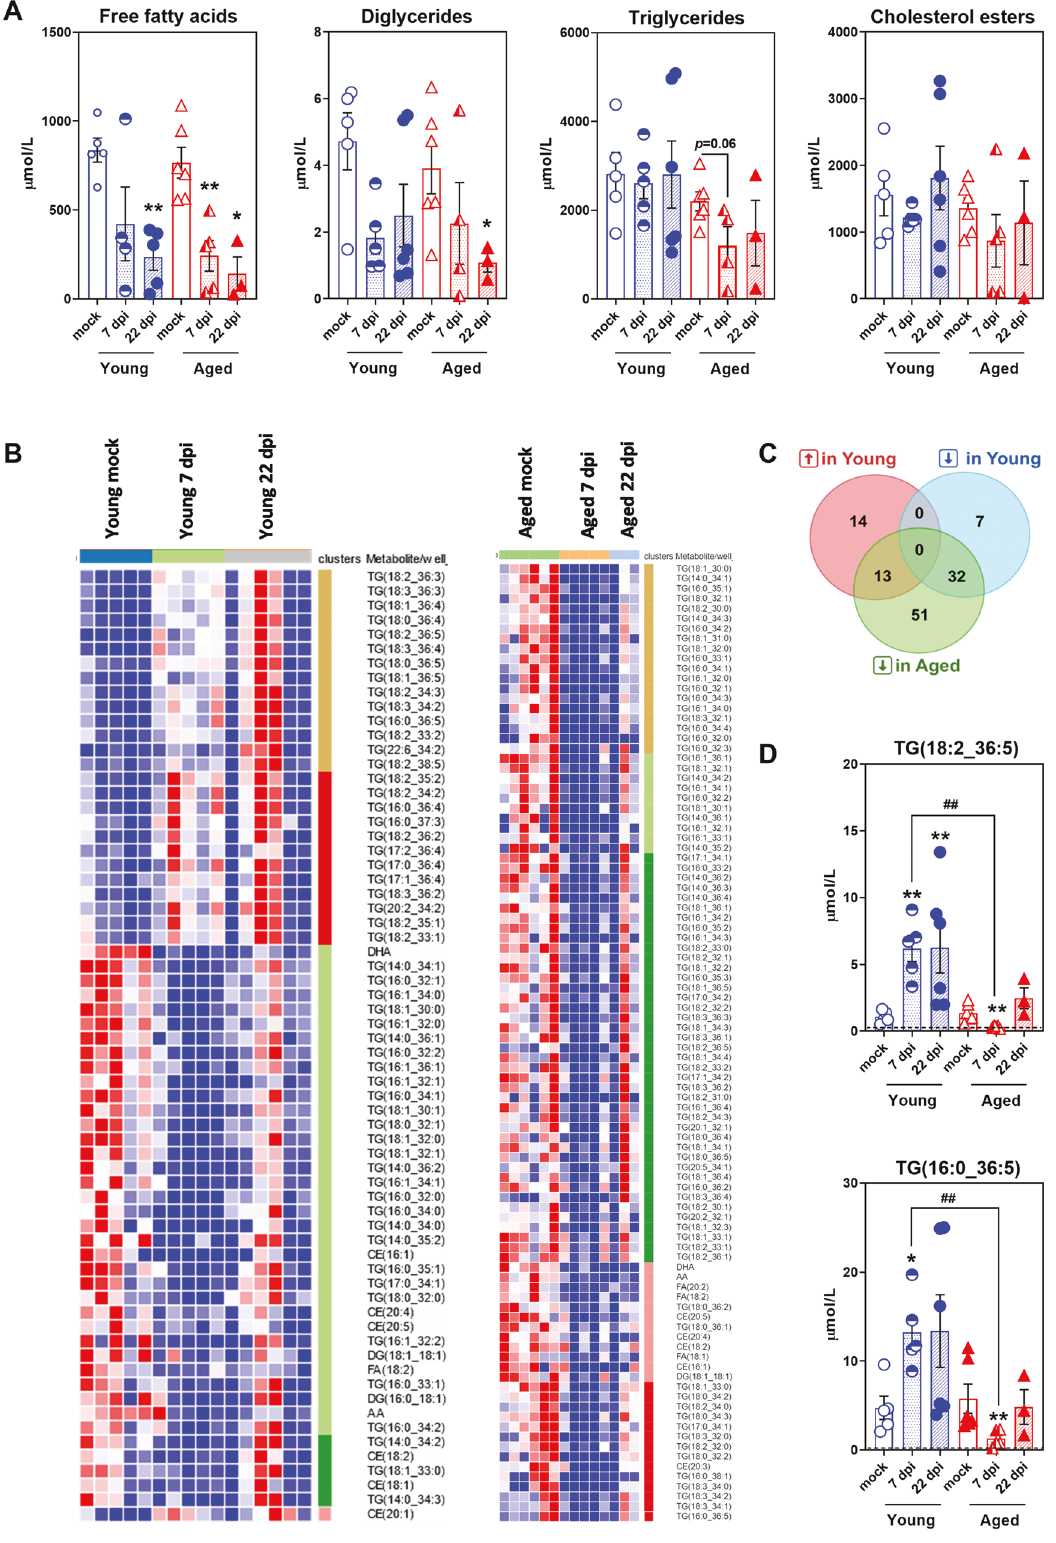
Animals, virus, and infection Male golden (Syrian) hamsters ( Mesocricetus auratus ), 2-months-of-age (the “ young adults ” group) and 22-months-of-age (the “ aged adults ” group), were purchased from Janvier Labs (Le Genest-Saint-Isle, France). Hamsters were fed a standard rodent chow (SAFE ® A04, Augy, France) and were